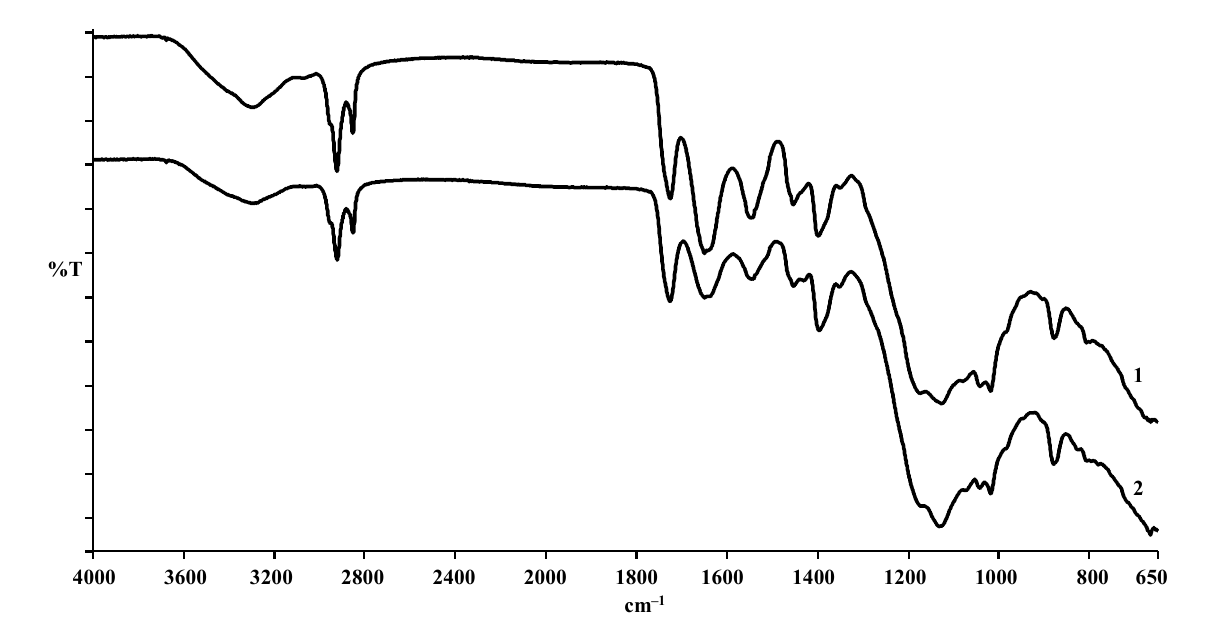
Figure 3. IR-spectra of hide. 1—pickled conventionally; 2—pickled adding EP Zime SB 3%.